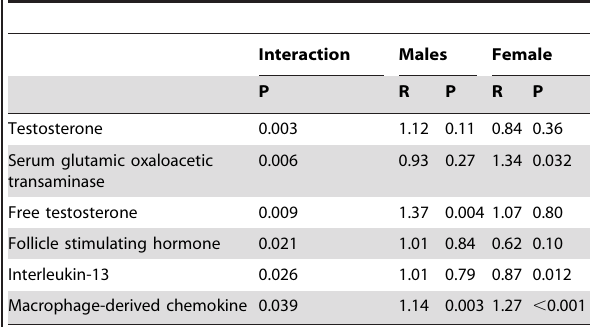
Table 6. Summary of analytes with sex-specific treatment